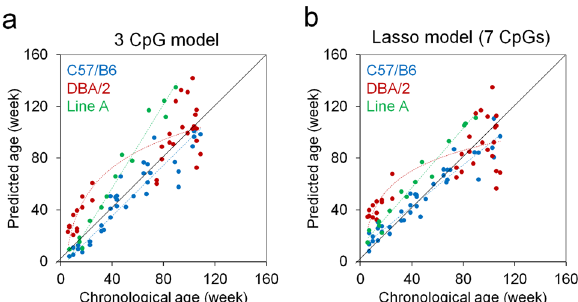
Figure 5. Age-predictions with BBA-seq in mice from different genetic background. DNAm levels were analyzed with BBA-seq in blood samples of 40 C57BL/6 mice of the validation sets, 33 DBA/2 mice, and 15 transgenic C57BL/6 mice with an age-associated region from DBA/2 mice (Line A) 18 . For epigenetic age predictions we either used ( a ) the 3 CpG multivariable model, or ( b ) the lasso regression model based on 7 CpGs of the same three amplicons ( Prima1 , Hsf4 , Kcns1) . As previously described for pyrosequencing, epigenetic age-predictions were logarithmically accelerated in DBA/2 mice 17 , and also accelerated in Line A mice 18